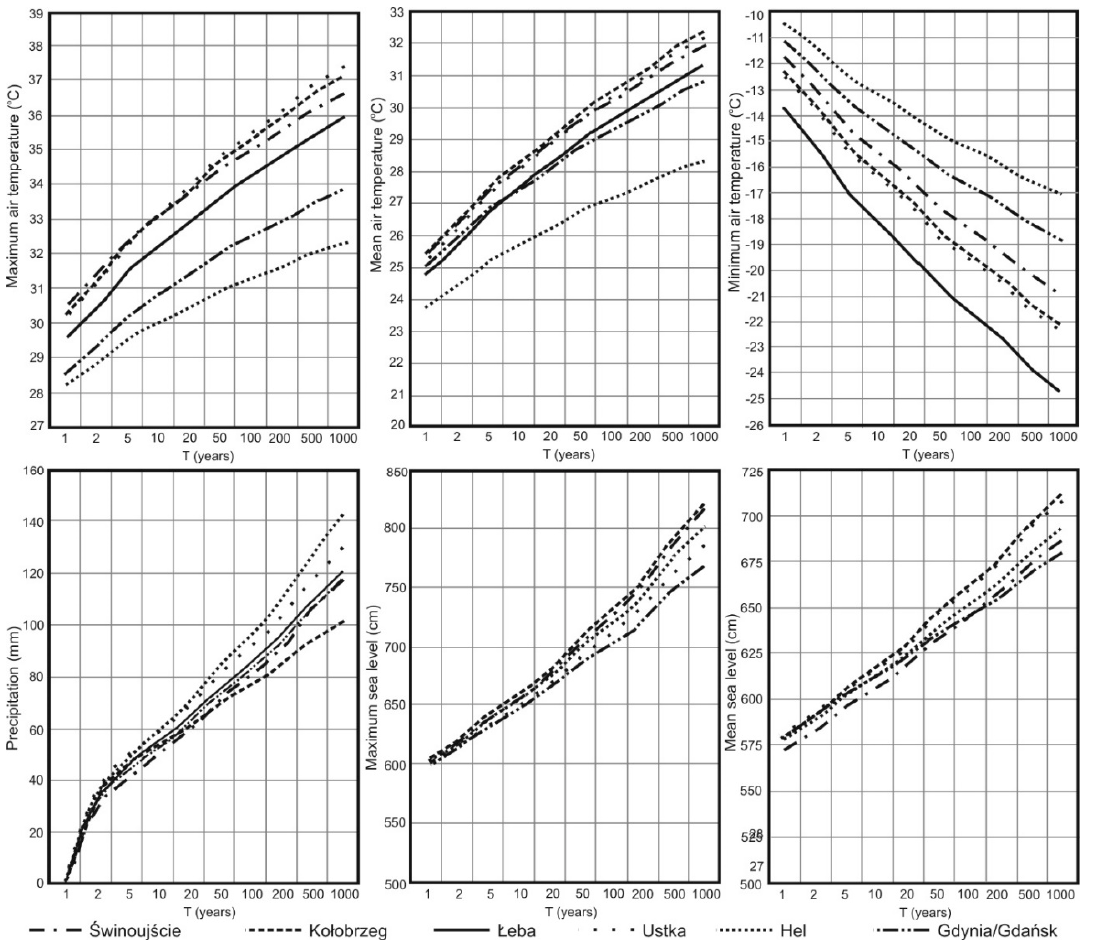
Figure 2. Threshold values for the probability (return period) of extreme hydrometeorological events in the Polish Baltic coastal zone.